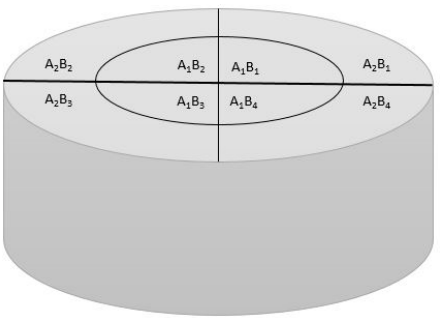
Figure 2. Schematic of partitioned surface of the samples used for microhardness measurement.